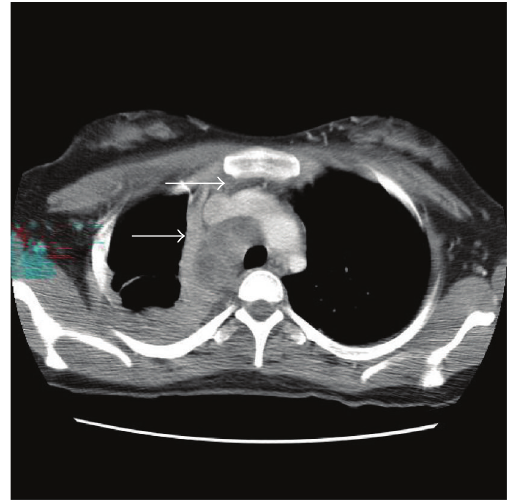
Figure 2: Computer tomography of the chest. Extensive mediasti- nal soft tissue mass in the right paratracheal region extending into the hilar and subcarinal region.